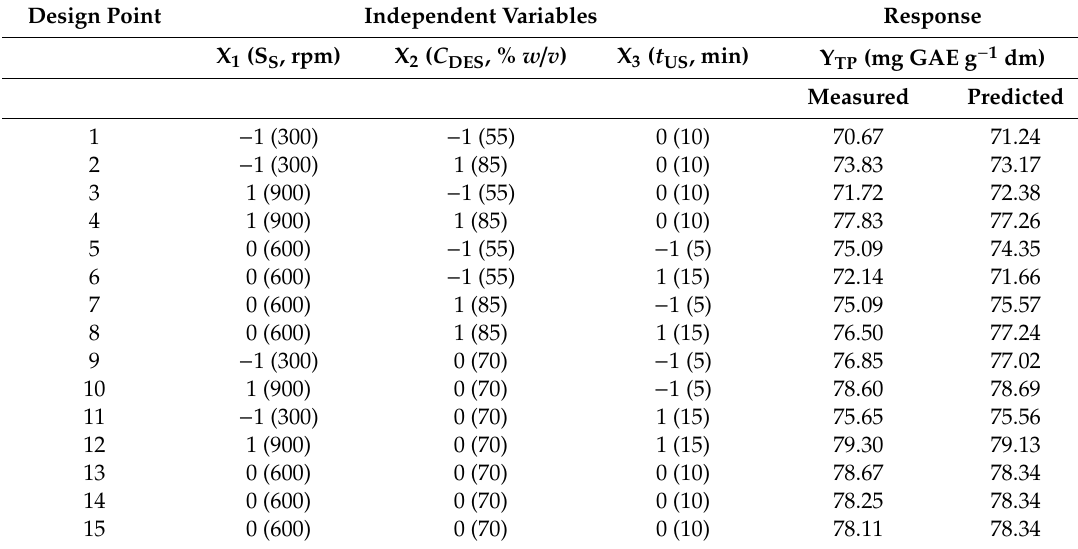
Table 2. Analytical presentation of the design of experiment (design points), including predicted and measured values of the response.